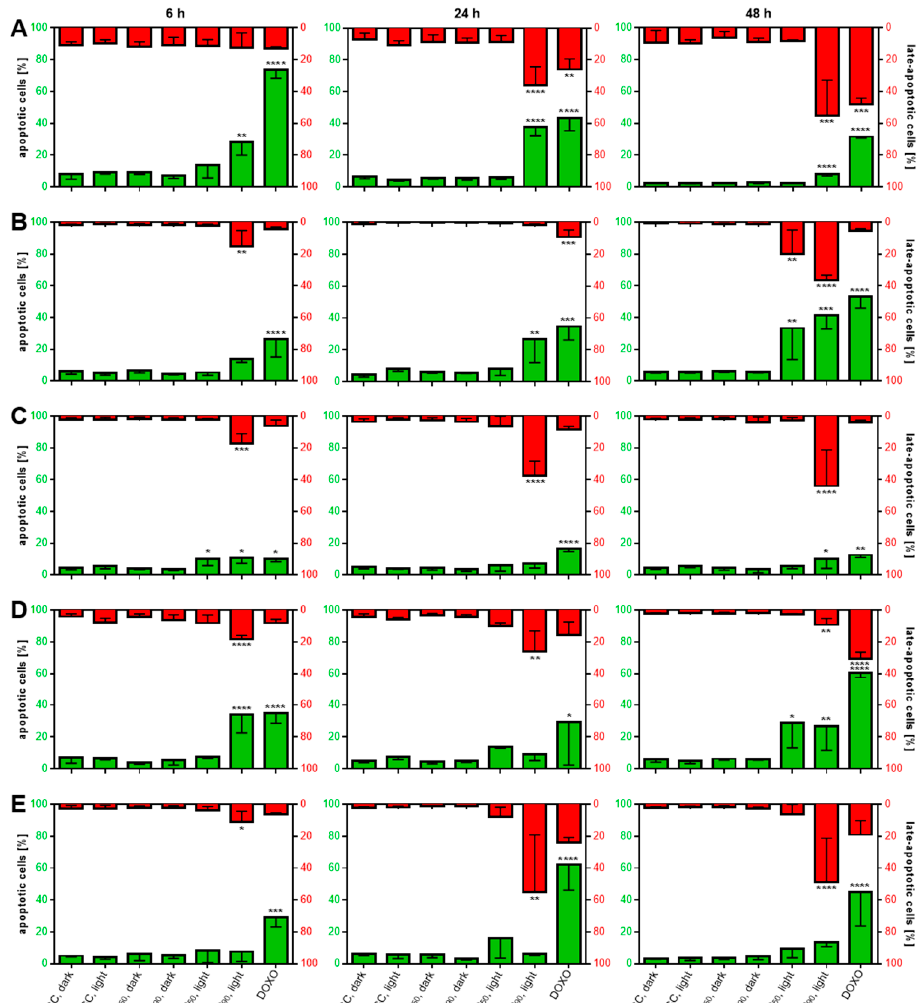
Figure 6. Induction of apoptosis, measured by phosphatidylserine externalization after mTHPC-PDT in A-427 ( A ), BHY ( B ), KYSE-70 ( C ), RT-4 ( D ), and SISO ( E ) cells. Cells were treated with either solvent (SC) or equitoxic concentrations (IC 50 or IC 90 in Table 1) of mTHPC between 0.02–0.3 µM, illuminated with 1.8 J/cm 2 or left in the dark, stained with Annexin V-FITC and propidium iodide (PI) and analyzed 6 (left), 24 (middle), or 48 h (right) after photodynamic treatment. Flow cytometric analysis of the single cell population was carried out using the FITC channel ( λ Ex / Em = 488 / 525–550 nm) for the detection of Annexin V-positive cells and the PI channel ( λ Ex / Em = 488 / 655–730 nm) for PI-positive cells. The percentage of apoptotic cells is plotted on the left axis, while late-apoptotic cells can be seen on the right axis in opposite direction. Non-illuminated, solvent-treated cells served as the reference sample; cells treated with 0.5–5.0 µ M DOXO were used as positive control. Data presented as means ± SD from at least three independent experiments. ( * p < 0.05; ** p < 0.01; *** p < 0.001; **** p < 0.0001).